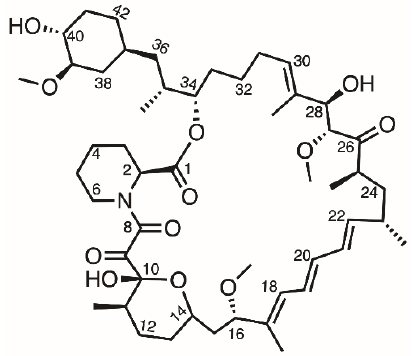
Figure 1. Structure of sirolimus.